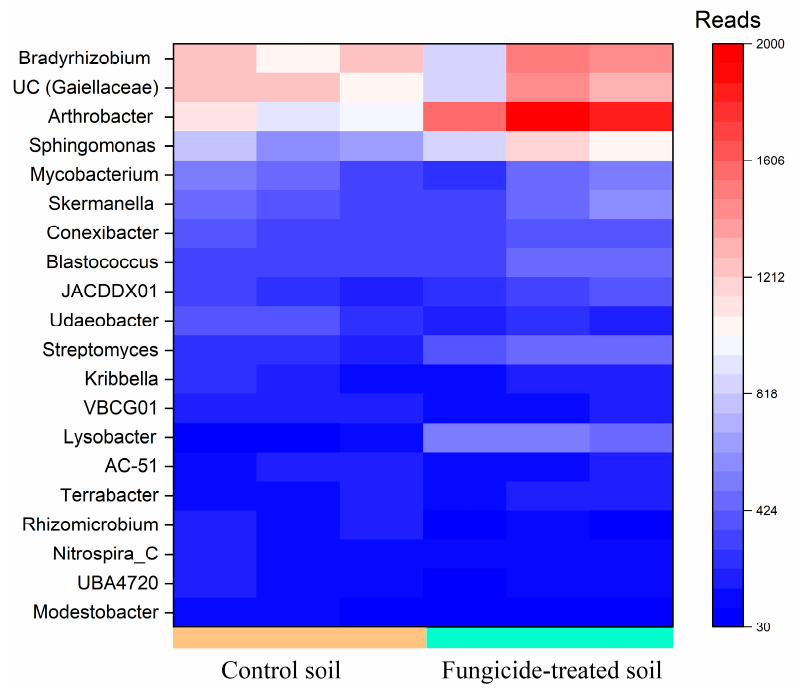
Figure 2. Heatmap of the relative abundance of bacterial genera, estimated on the basis of ASV reads.